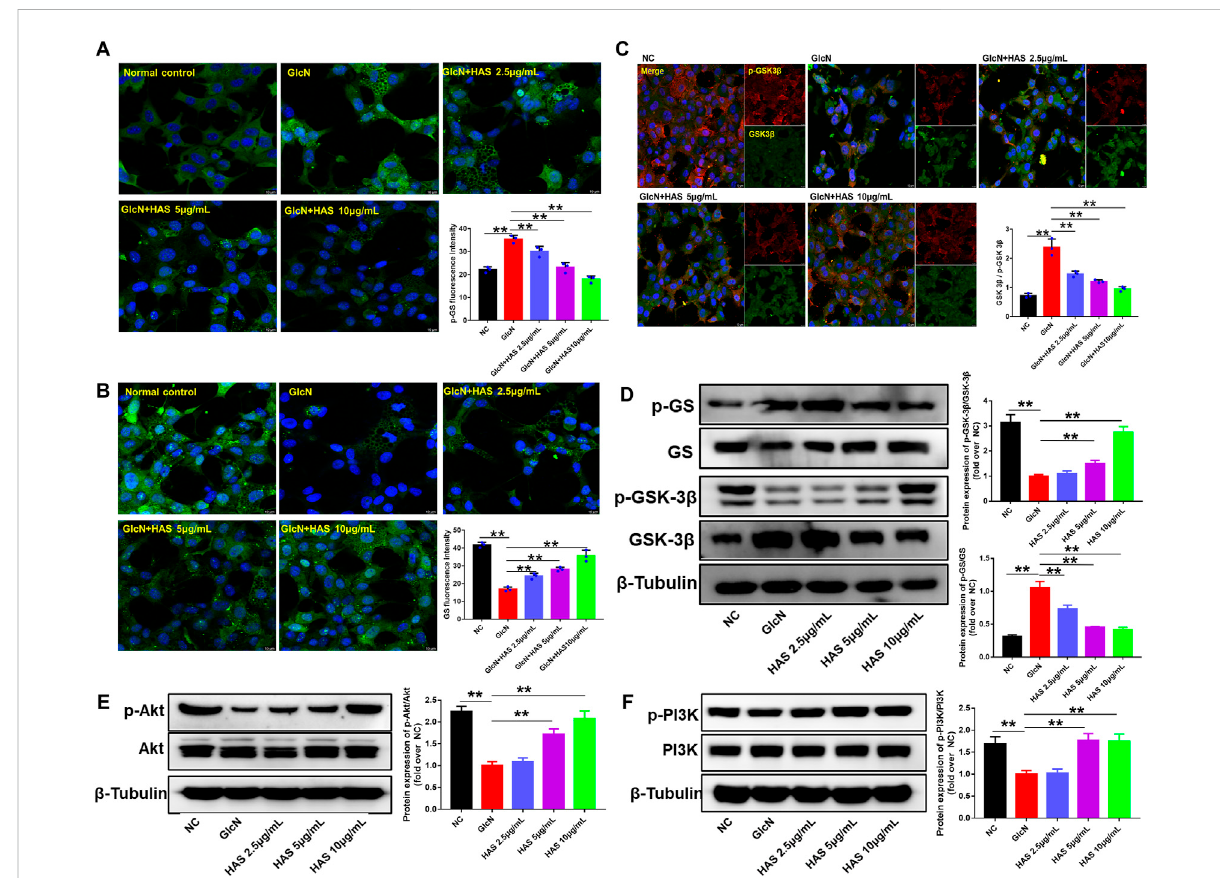
FIGURE 5 Effects of HAS on expression of PI3K/Akt/GSK-3 β signaling pathway proteins in GlcN-induced HepG2 cells. (A,B) HAS decreased the phosphorylation of GS in GlcN-induced HepG2 cells. (C) HAS increased the expression of p-GSK-3 β /GSK-3 β in GlcN-induced HepG2 cells. (D) Westernblottingassaysofp-GS,GS,p-GSK-3 β ,andGSK-3 β inGlcN-inducedHepG2cells. (E,F) HASincreasedthephosphorylationofPI3KandAktin GlcN-induced HepG2 cells. Data are expressed as mean ± SD ( n = 3), * p < 0.05, ** p < 0.01 vs. GlcN-induced HepG2